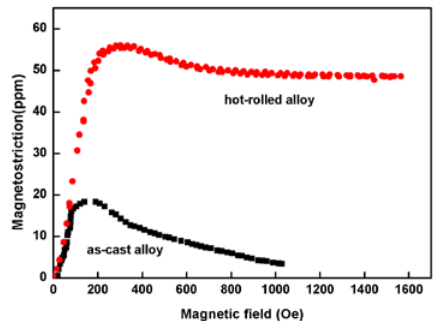
Figure 1. Magnetostriction for the two states of Fe 85 Ga 15 alloys.